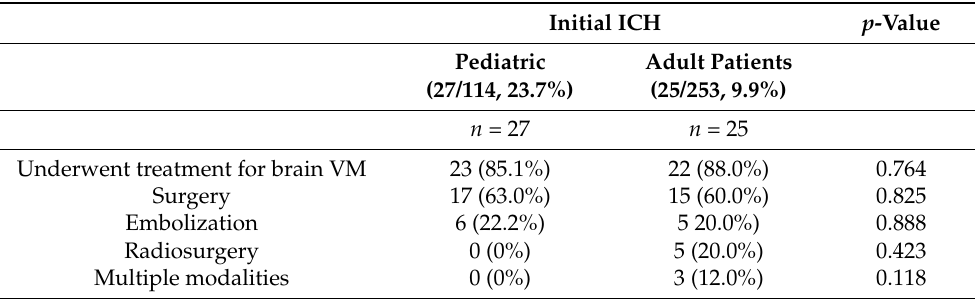
Table 5. Treatment for brain VMs complicated by ICH at initial